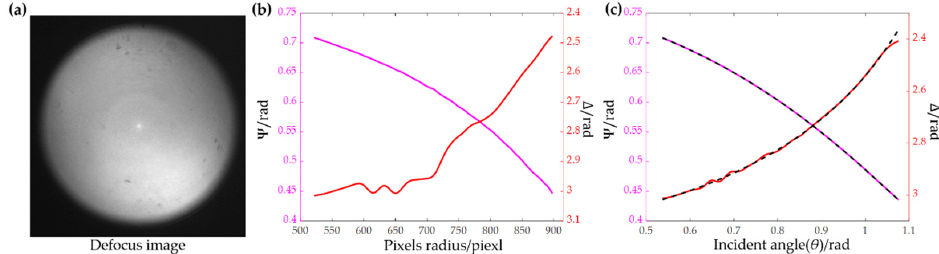
Figure 6. A defocus-effect correction example of the proposed BFP ellipsometry: ( a ) a defocus BFP image of SiO 2 film; ( b ) directly obtained ellipsometric parameters; ( c ) theoretical and measured value after incident angle calibration and compensation of the ellipsometric parameters; black lines represent the theoretical values and colorful lines represent the measured values after correction.